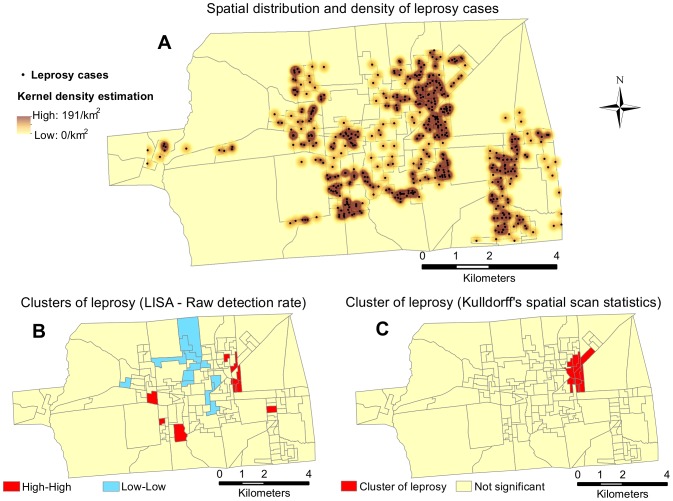
Clusters of leprosy in Castanhal.(A) The spatial distribution of individual leprosy cases overlying the respective Kernel density estimation layer, representing areas with a high and low density of cases per km2. (B) LISA test (local Moran's I) characterizing areas with a statistically significant (p<0.05) positive spatial association according to the raw detection rate. The areas marked as high-high indicate a high rate in an area surrounded by high values of the weighted average rate of the neighboring areas, and low-low represents areas with a lower rate surrounded by lower values. (C) The most likely cluster of leprosy detected by the Kulldorff's spatial scan statistics (p<0.01).